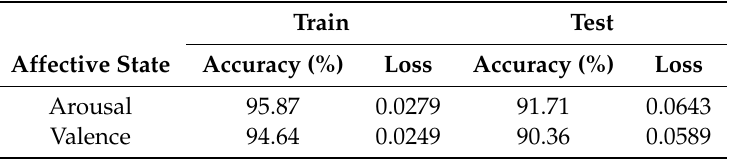
Table 8. Full classification system results: GSR and ECG combined.